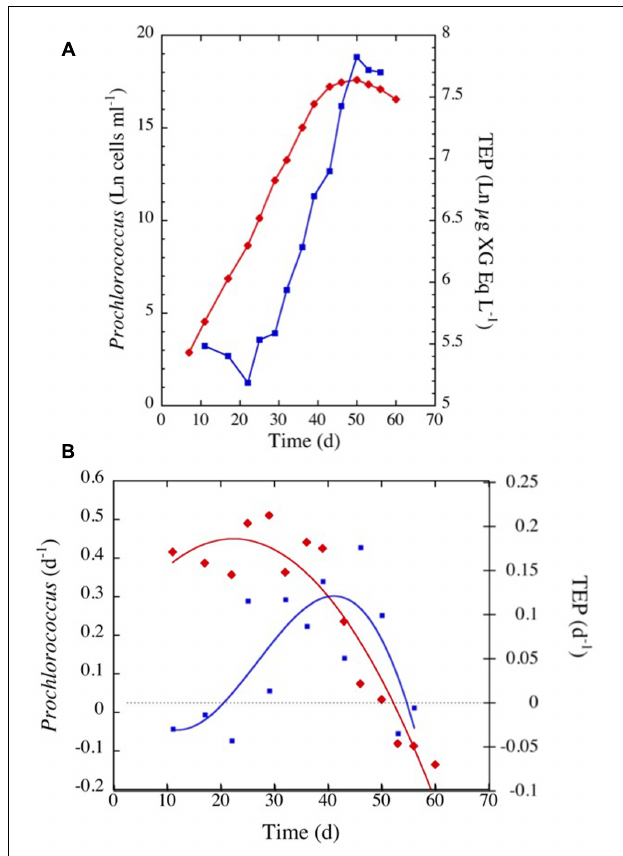
FIGURE 7 | (A) Exponential increase with time in TEP concentrations (blue squares and line) and in cell abundance (red diamonds and line) observed in the culture of Prochlorococcus marinus under laboratory conditions. (B) Changes in P. marinus specific growth rate (red diamonds) and TEP production (blue squares) with time. The blue and red lines represent the polynomial fits for TEP (order 5) and growth (order 2) specific rates,